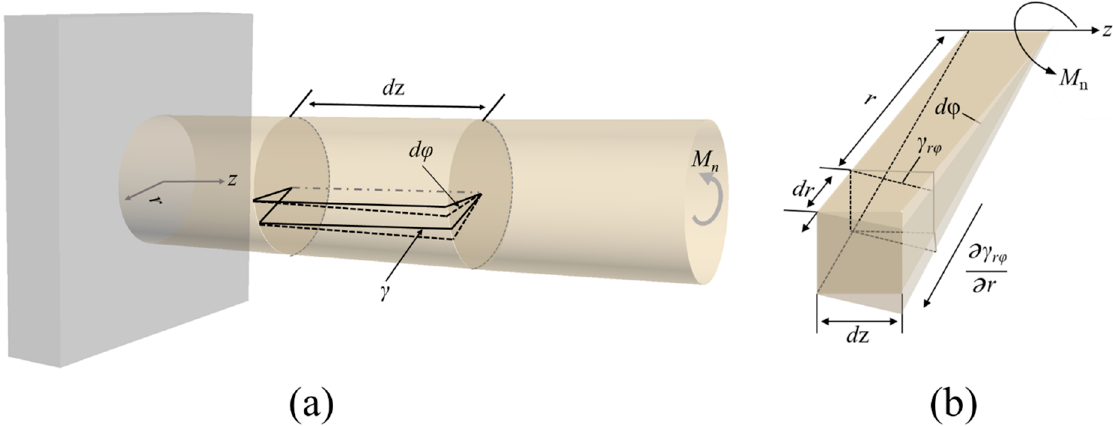
Figure 7. ( a ) Schematic of shear and deformation under the torque value. ( b ) Infinitesimal analysis of the shear strain gradient.